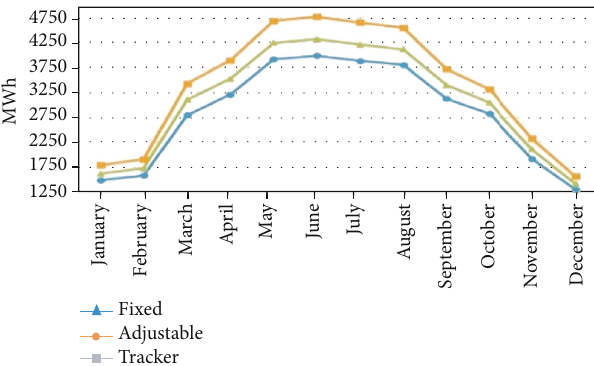
Figure 6: Comparison of October production data.